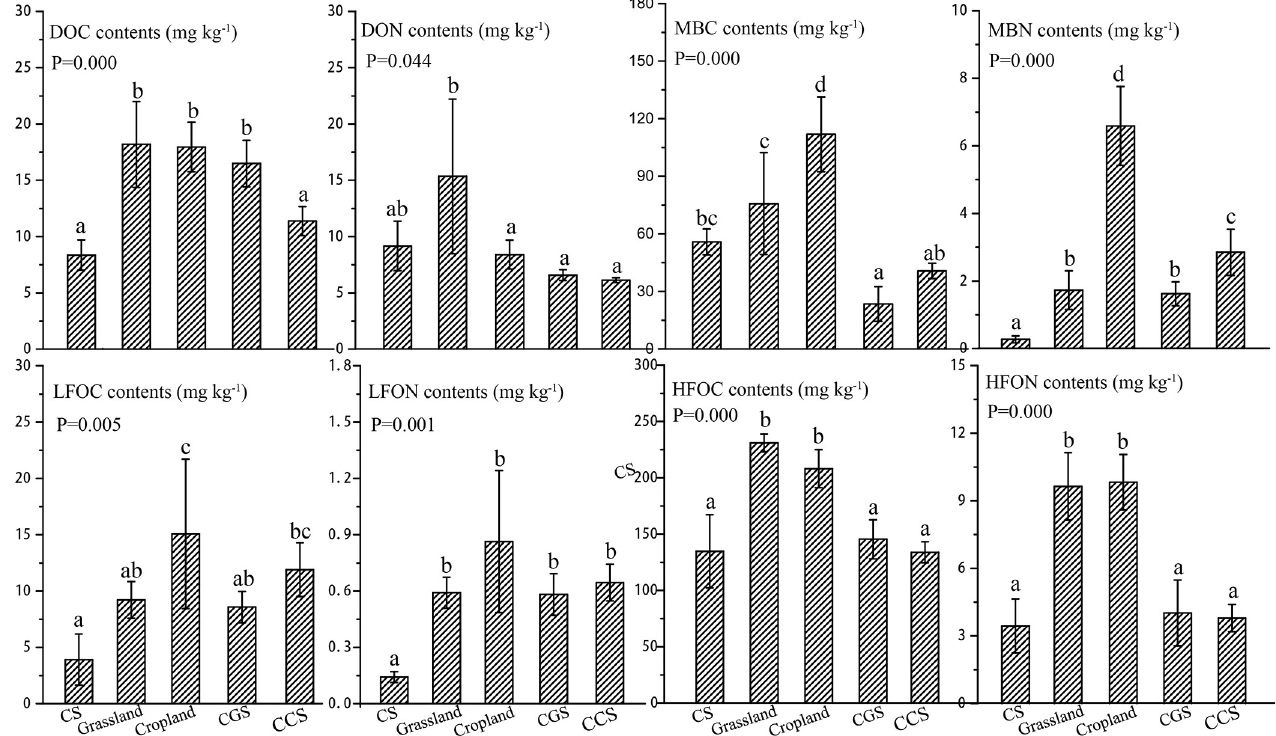
Fig 2. Contents of C and N fractions in the five land-use types. Different letters on bars in each carbon fraction indicated significant differences at α = 0.05 level (Duncan test).